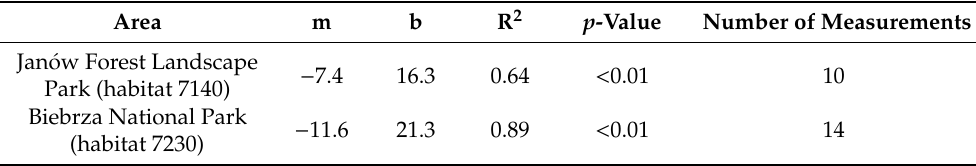
Figure 2. The non-water-stressed baseline (NWSB) for ( A ) habitat 7140 and ( B ) habitat 7230. Table 3. The NWSB statistics and parameter values for each habitat.